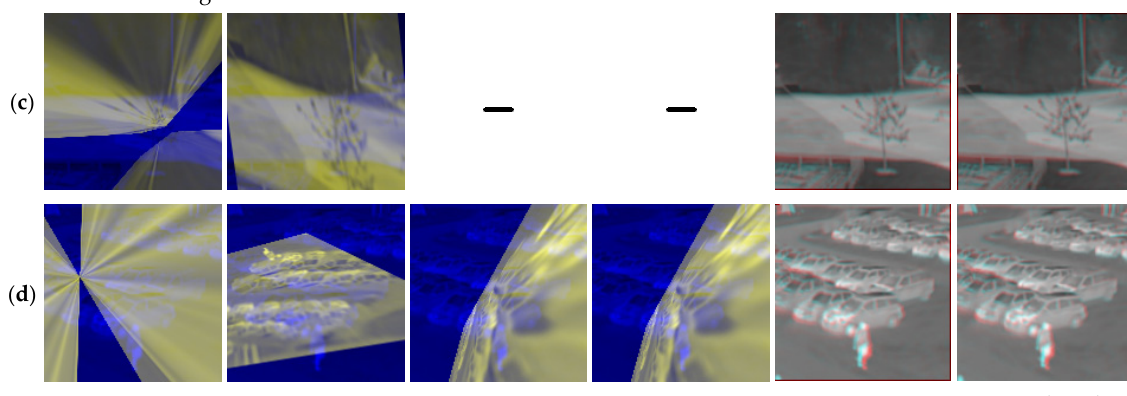
Figure 11. Quantitative comparison of HomoMGAN with deep learning-based methods on syn- thetic benchmark dataset. Discussions. The synthetic benchmark dataset comes from several real-world out- door scenes, including parking lots, schools, parks, etc. After experimental verification, our method can obtain a more accurate homography matrix in these scenarios, and the registration effect is more reasonable. Since the essence of our synthetic benchmark da- taset comes from registered real-world datasets, which to some extent reflect the unregis- tered situation of real-world data, our method also effectively performs when using un- registered real-world datasets. 4.4. Ablation Experiment Shallow feature extraction network. The effectiveness of the shallow feature extrac- tion networks was mainly verified from two perspectives relating to the synthetic bench- mark dataset. First, the shallow feature extraction network was replaced with the feature extractor and mask predictor [15], whose feature map comparison is shown in Figure 12. The main reason that this replacement was undertaken is that they function similarly; they both obtain weighted feature maps, highlighting features that are meaningful for homogra- phy estimation. As shown in Figure 12, it can be seen that the feature maps produced by our shallow feature extraction network are sparser, which is beneficial in reducing the noise in the feature maps. To prove the effectiveness of our shallow feature extraction network more